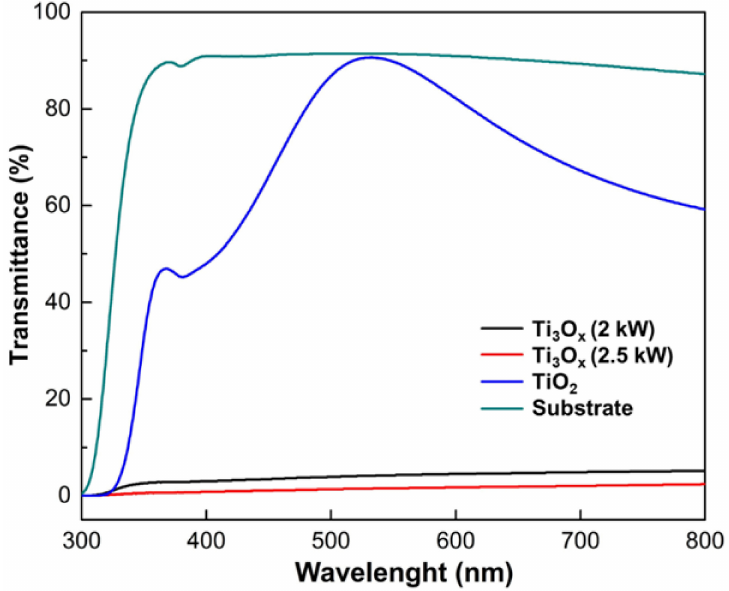
Figure 7. UV–Vis transmittance spectra of the Ti 3 O x thin film deposited at 2 and 2.5 kW compared with TiO 2 thin film.